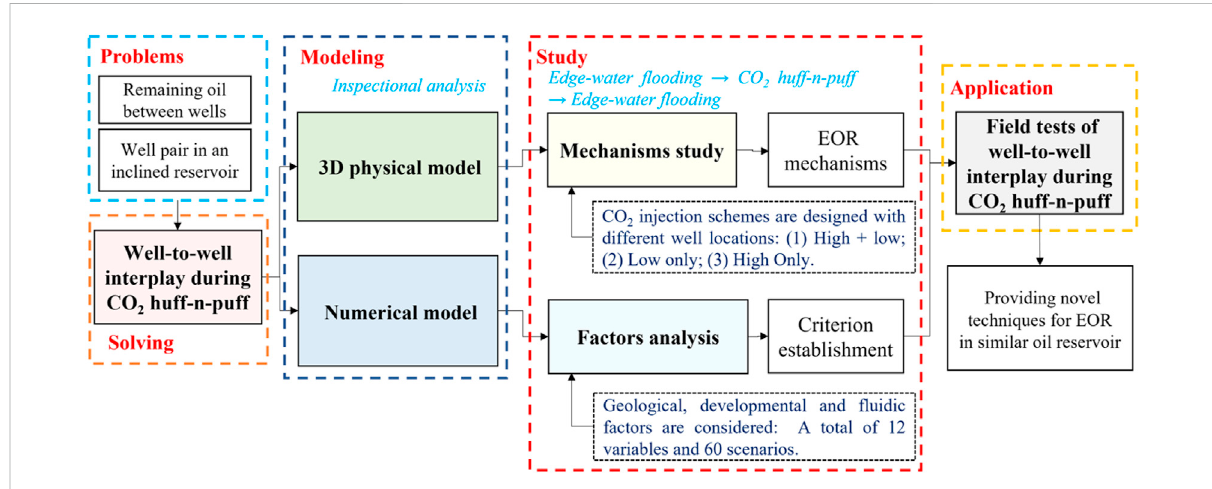
FIGURE 2 Technical route and major steps used in the study of well-to-well interplay of CO 2 huff-n-puff.